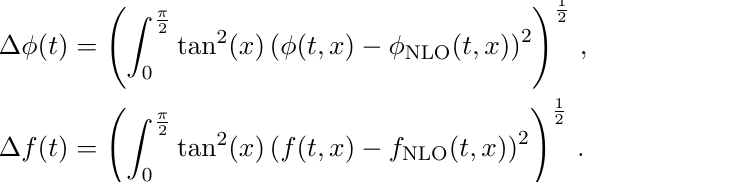
Figure 37 . Time evolution of (cid:1) (cid:30) (blue) and (cid:1) f (red). We compare the end (cid:12)eld con(cid:12)gurations (cid:30) and f after the quench with two nonlinear oscillons: one with ! NLO = 2 : 9 (left), and another one with ! NLO = 2 : 89992 (right). The agreement is better in the second case. the oscillation of real quantitities. The fast oscillations pile up and, due to their high density, form the blue shaded area visible in the (cid:12)gure. Now, instead of (3.6){(3.7), we de(cid:12)ne two new quantities, ((cid:1) (cid:30) ,(cid:1) f ), which measure the distance to the nonlinear oscillon ( (cid:30) ; f ) built with the target NLO NLO